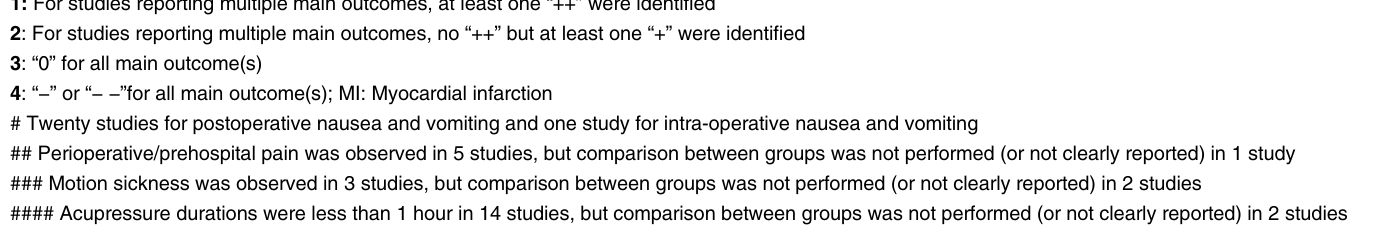
Results of Therapeutic